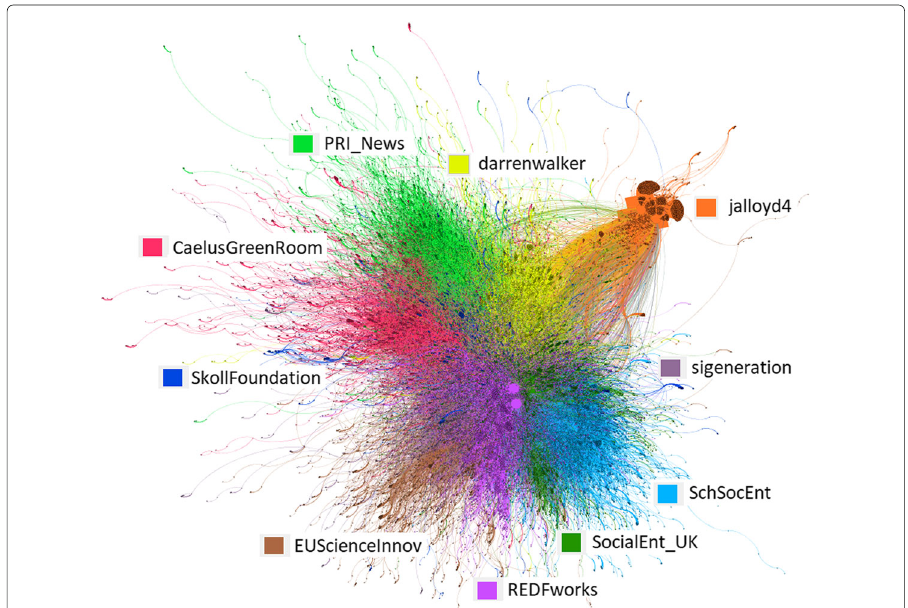
Fig. 3 Retweet communities, each identified with the most influential Twitter user, as measured by the